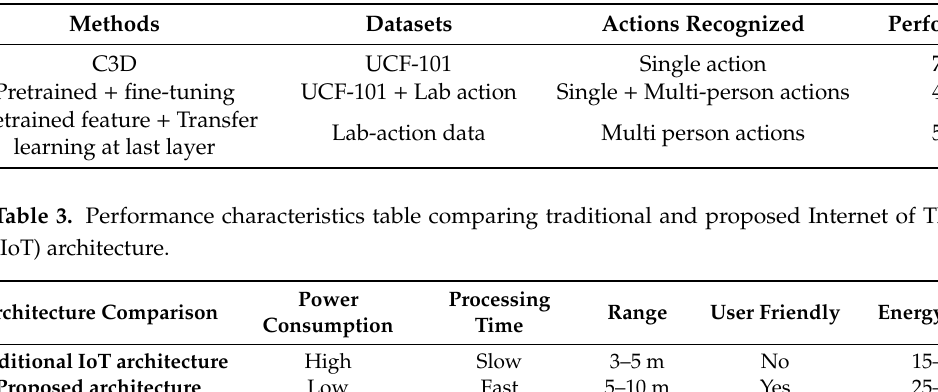
Figure 5. Images of di ff erent student actions in a smart classroom room for video data collection. Table 2. Action recognition performance in lab-action dataset versus UCF-101 data.